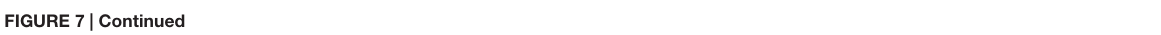
( Figure 8 and Supplementary File S5). The molecular and